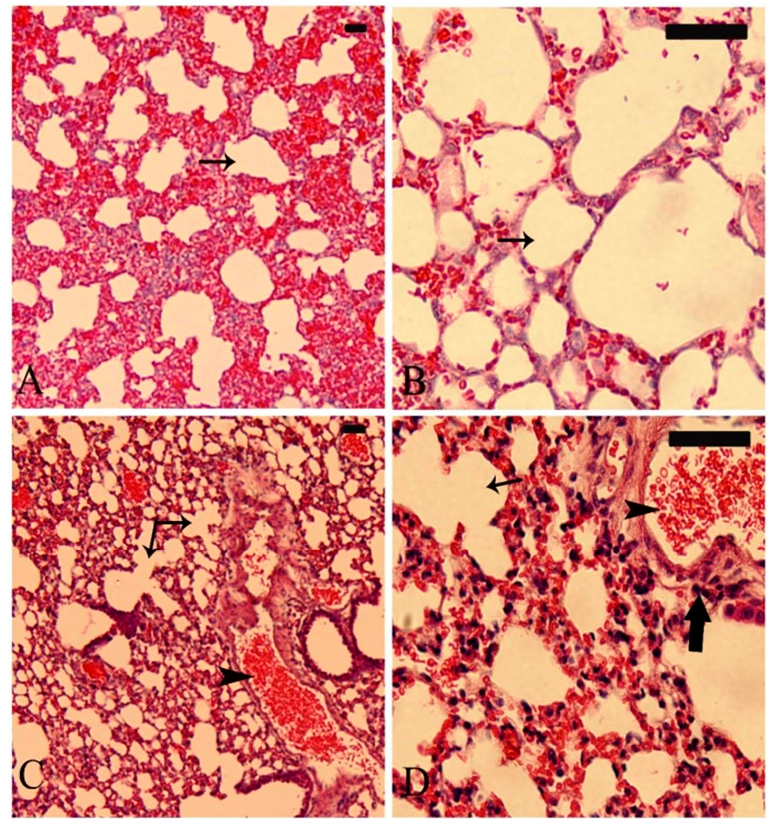
Figure 6. Photomicrographs of H&E-stained sections in lung sample of G. nanus from the control site ( A , B ) showing normal structure of the bronchioles and alveoli (arrow), and the lung of animals from the mining site ( C , D ) showing dilated alveoli (thin arrow), inflammatory cell infiltration (thick arrow), and congested blood vessels (arrow head). Scale bar = 100 μ m.